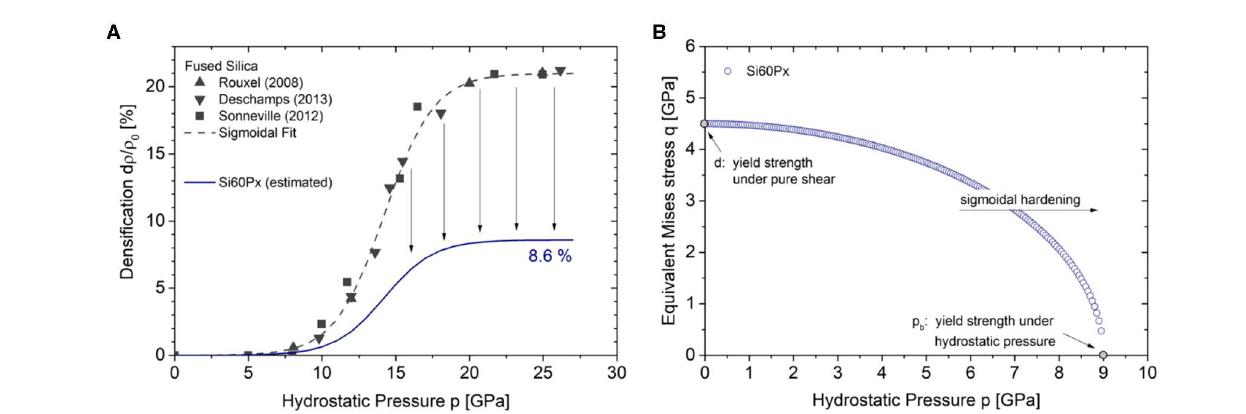
FIGURE 3 | (A) Densification hardening curve for the series with constant 60 mol% SiO 2 (Si60Px, dark blue) based on model predictions and experimental data on fused silica (open symbols). It serves as input for determination of the yield surface. The yield surface, shown in (B) , was used for FEA analysis of the Si60Px series (applies to all x values from 0 to 7.5 mol% P 2 O 5 because all glasses had similar Poisson’s ratio, see text).